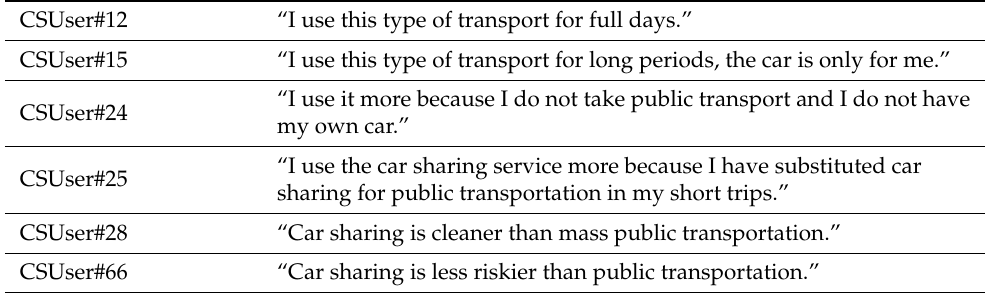
Table 3. Behaviour of participants whose car sharing usage increased.